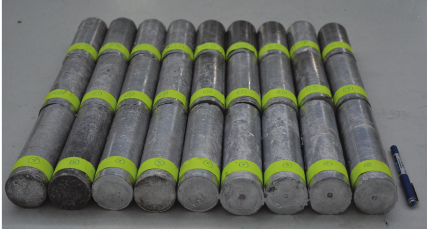
Figure 2: Cast samples made from squeeze casting